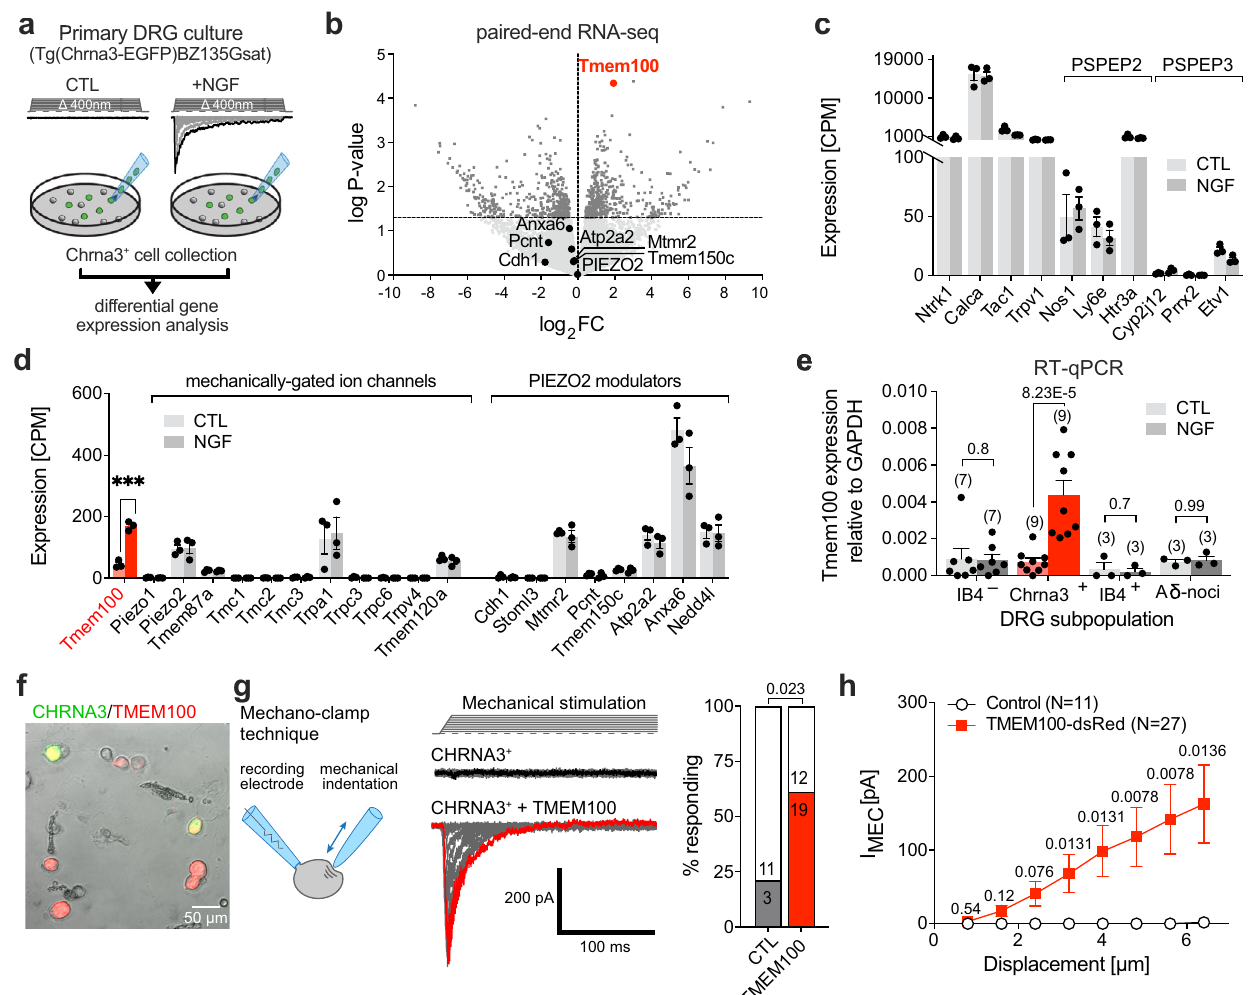
Fig. 1 | NGF treatment selectively upregulates TMEM100 in silent nociceptors. a CartoondepictingtheRNAseqscreenwork fl ow. b Volcanoplotshowingthemean fold-change of expression upon 24h NGF treatment (log 2 FC) vs. the log P -value determinedbypaired-endRNAseq( n =3biologicallyindependentsamples,20cells persample,fromthreedifferentmice;two-sidedStudent ’ sT-test). c Comparisonof the mean±SEM expression levels (counts per million, CPM) of peptidergic noci- ceptor subclass markers and d mechanically-gated ion channels and PIEZO2 modulators, determined by RNAseq in CHRNA3-EGFP + neurons cultured with and without NGF, using two-sided Students t-test (***, P =4.59843E-05; N -numbers are the same as in b ). e Comparison of the mean±SEM expression levelsof TMEM100 (normalized to GAPDH expression) determined by qPCR in the indicated noci- ceptorsubclasses,culturedwithout(CTL)andwithNGF.Toenableidenti fi cationof peptidergic C- fi ber nociceptors, non-peptidergic C- fi ber nociceptors and A δ - fi ber nociceptors for sample collection, cultures were prepared from Tg(Npy2r-cre) SM19Gsat/Mmucd x B6;129S-Gt(ROSA)26Sortm32(CAG-COP4*H134R/EYFP)Hze/J (Npy2r Cre ;ChR2-EYFP) mice, in which A δ - fi ber nociceptors express EYFP and were additionally labeled with Alex-Fluor-568 conjugated Isolectin B4 (IB4), which